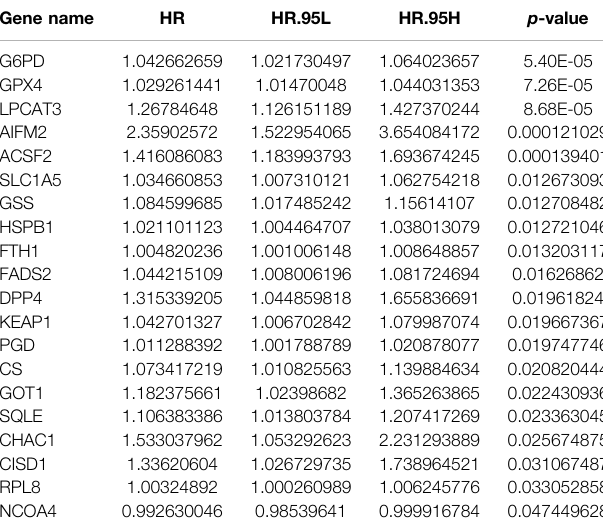
TABLE 2 | Ferroptosis-related genes with survival signi fi cance in the univariate Cox regression analysis of the TCGA-LAML